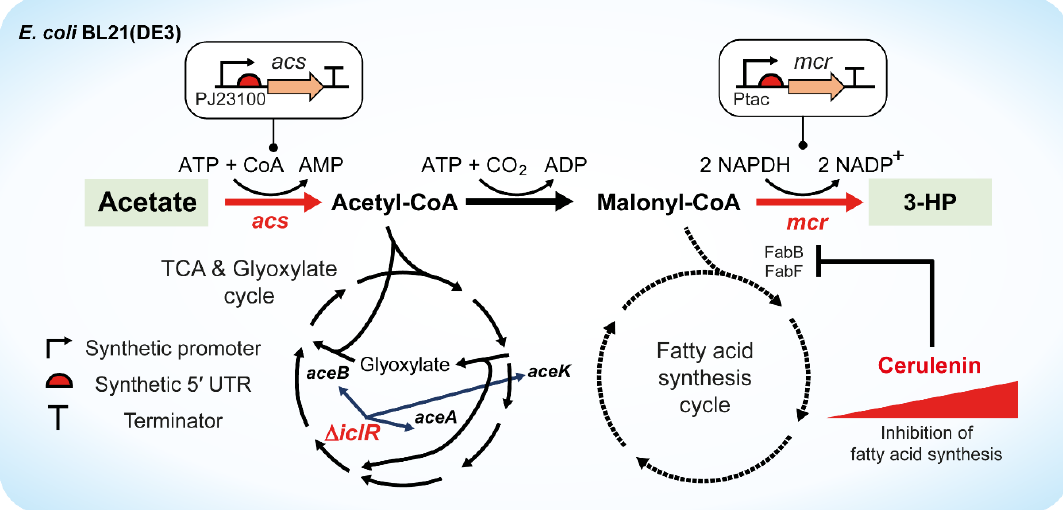
Figure 1. Schematic diagram of a metabolic pathway for the 3-HP production from acetate. 3-HP was synthesized by heterologous overexpression of mcr (encoding malonyl-CoA reductase from C. aurantiacus ). For accelerated acetate assimilation, acs (encoding acetyl-CoA synthetase) was overexpressed and iclR (encoding glyoxylate shunt pathway repressor) was deleted. Deletion of iclR upregulates the expression of aceA (encoding isocitrate lyase), aceB (encoding malate synthase), and aceK (encoding isocitrate dehydrogenase kinase/phosphatase). Phosphorylation of isocitrate dehydrogenase (encoded by icd ) results in its reduced activity. Different amounts of cerulenin were added to inhibit fatty acids biosynthesis.